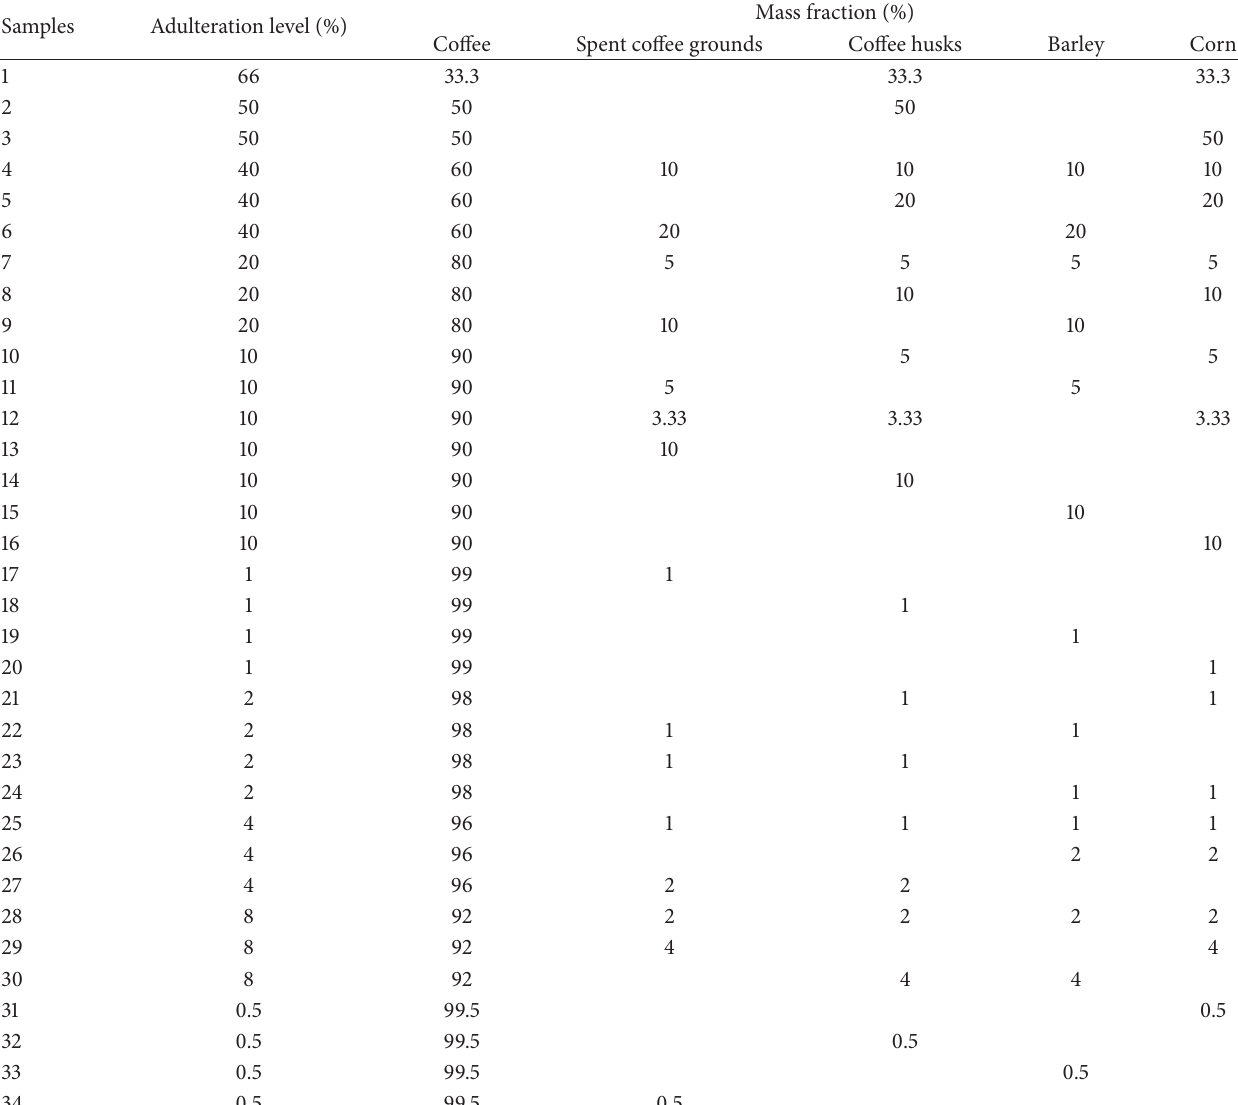
Table 1: Mass composition of adulterated coffee